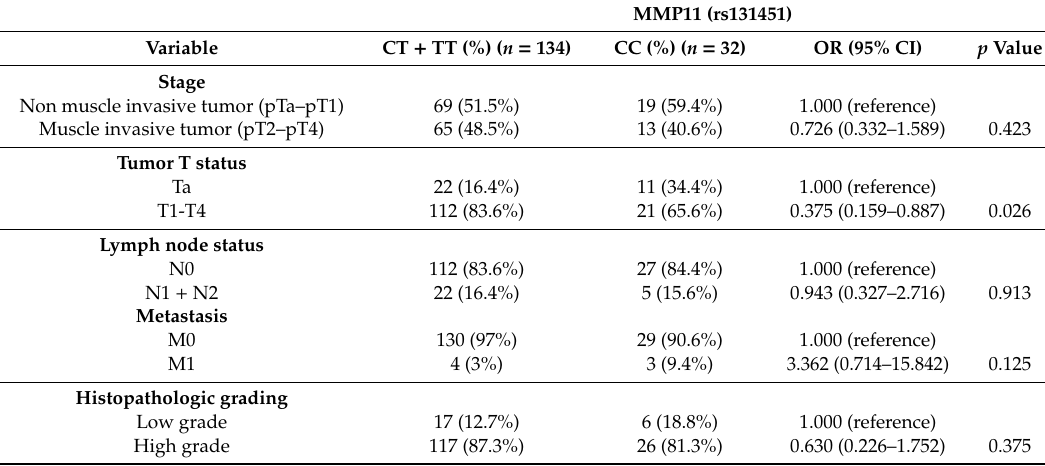
Table 4. Distribution frequency of the clinical status and MMP11 (rs131451) genotype frequencies in 166 UCC patients among age ≤ 65 years